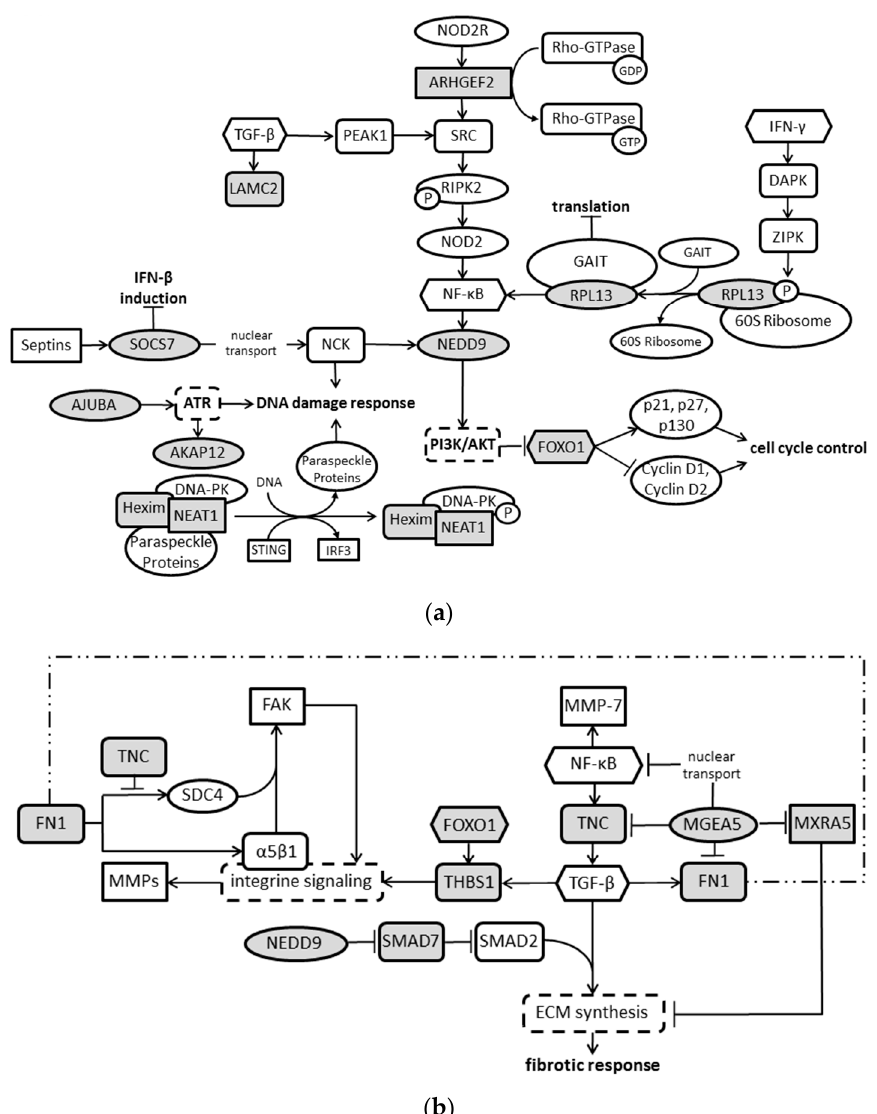
Figure 4. Overview of possible molecular interactions with regard to the 54 HBoV-regulated transcripts. The diagrams show the so far published interactions of HBoV-regulated target molecules, highlighted in grey, without consideration of up- or downregulation and protein–protein or protein–nucleic acid interactions. Arrows indicate induction or activation, whereas bars represent inhibitory effects. Proteins regulated by HBoV are involved in DNA damage response, translational regulation, and cell cycle control ( a ), and furthermore influence integrin signaling, which in parts overlap with TGF- β signaling, and the metabolism of the extra cellular matrix ( b ).